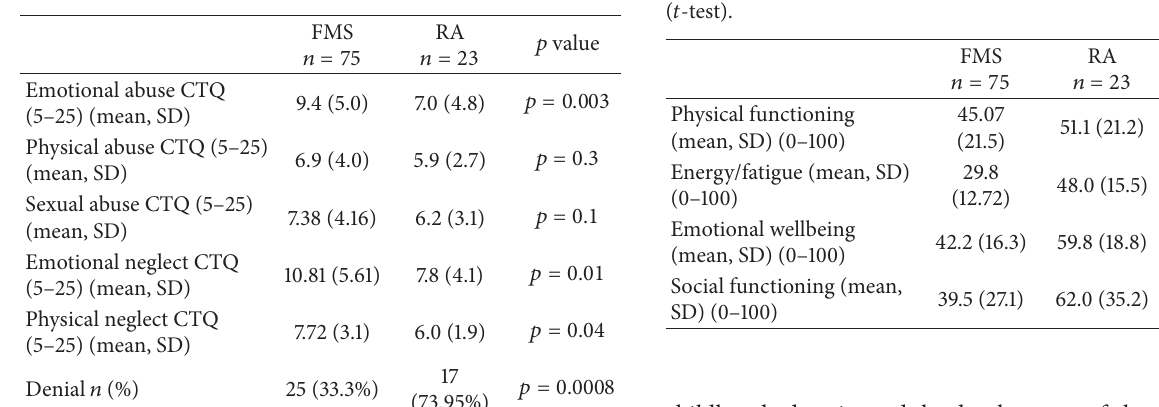
Table 6: Comparisons of retrospective reports of childhood mal- treatment of Israeli patients with FMS and RA.